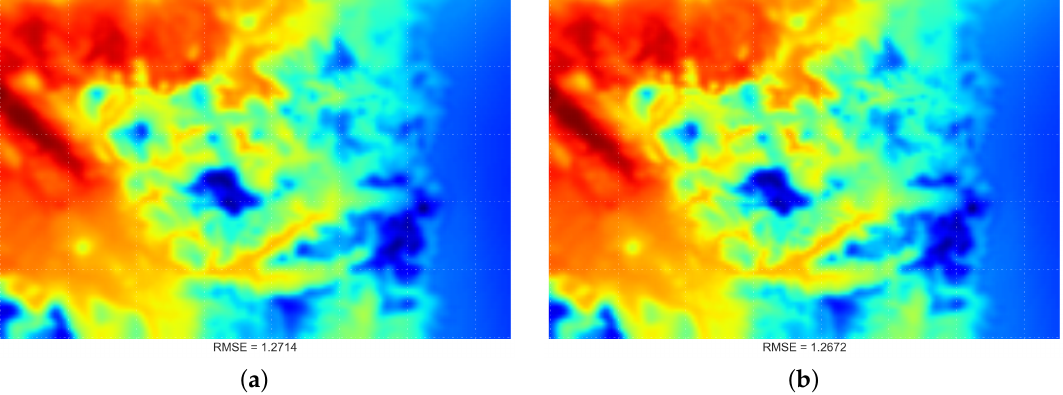
Figure 12. Visualisation output for the comparison results between the extension- and reduction-based STI methods. In this output, we used the scheme involving plus-and-minus one time index.